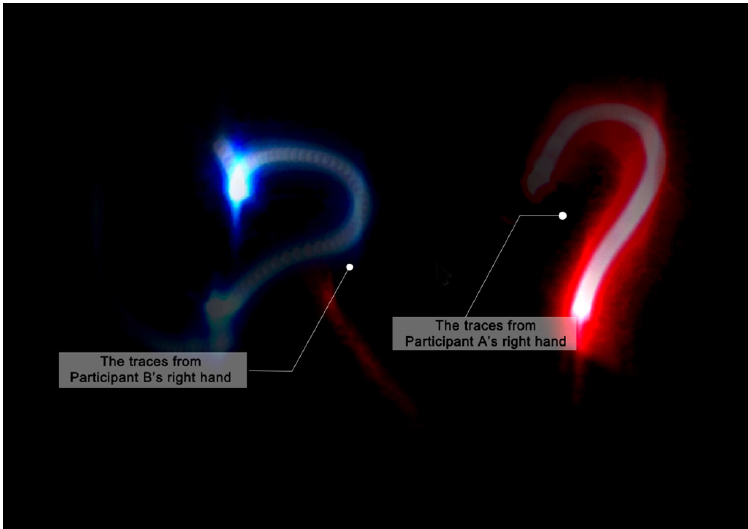
Figure 2. Light-emitting diode (LED) light tracks.